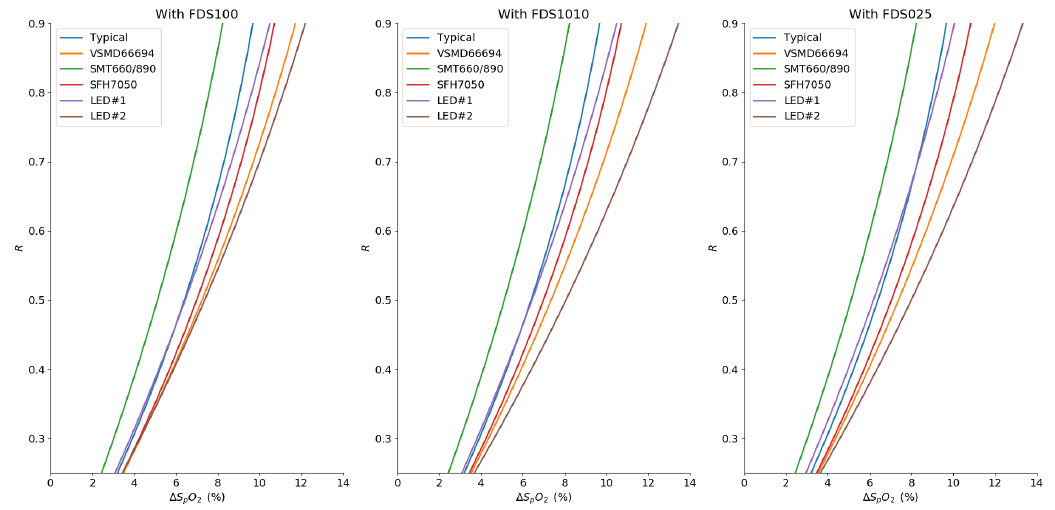
Figure 9. ( a ) Evaluation of the differential shift from the standard values of ε Hb and ε HbO selected source pairs (red dots for the red source and grey dots for the IR source) ( b ) Simulation of the deviation from the linear approximation according to the BLL for four our selected R/IR source pairs, zoom in the 90–100% region of oxygen saturation.